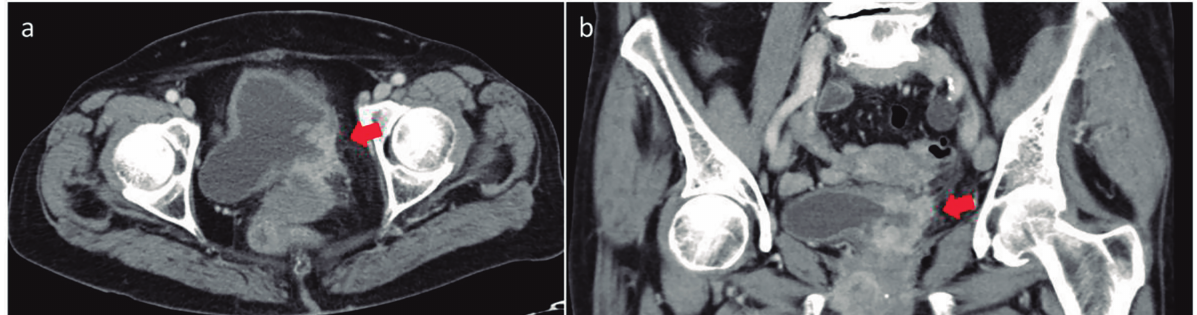
Figure 2 - Morphological characteristic of locally advanced tumor stage in CT scan Representative pelvic CT scan showing locally advanced tumor stage in transversal plane (A) and coronal plane